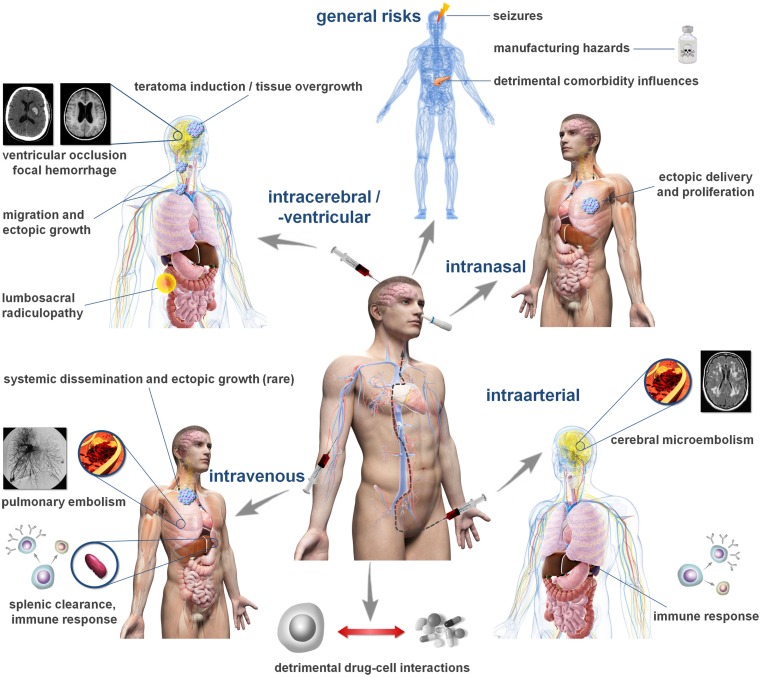
Cell administration routes and related complications. The figure depicts common routes investigated for cell and stem cell transplantation following stroke and potentially associated complications. The frequency of such complications can hardly be estimated from the available data in humans and may vary significantly between the individual elements. Please note that not all cell populations exhibit the same risk profile. For details, please consult Tables 1 and 2.